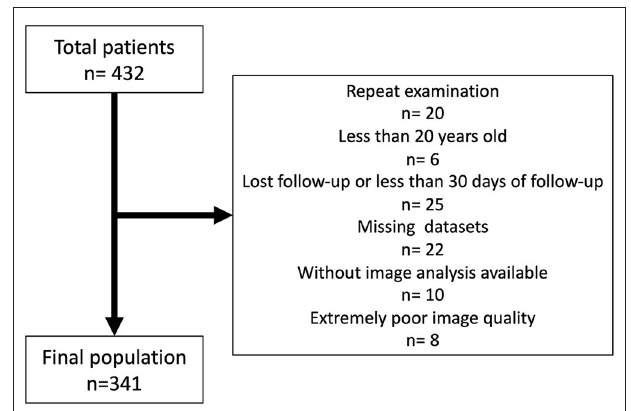
FIGURE 2 | Flow chart of the study